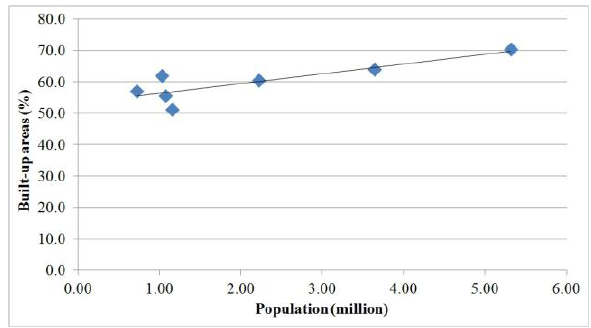
Figure 13. Relationship between the percentage of built-up areas and total employment for 2005 ( R 2 = 0.72)